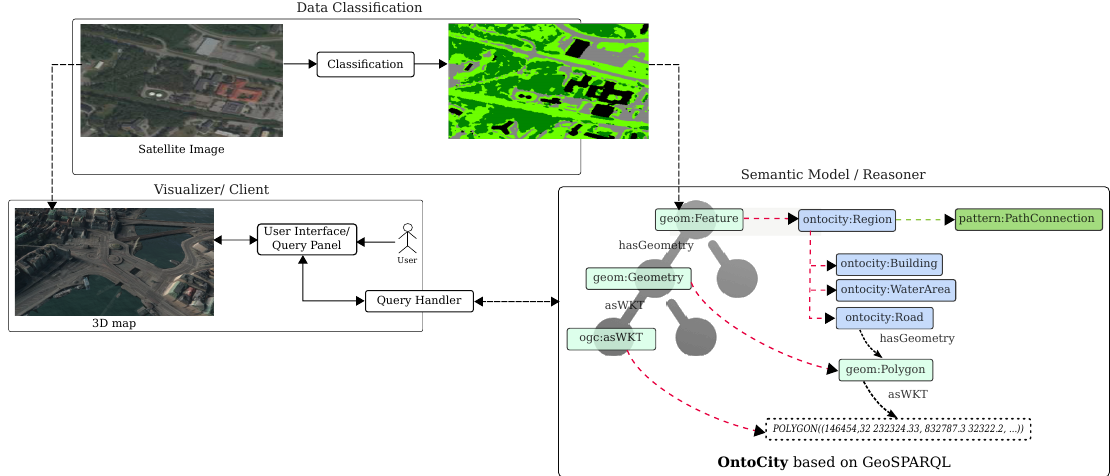
Figure 8. Semantic Representation and Reasoning as the main component of SemCityMap